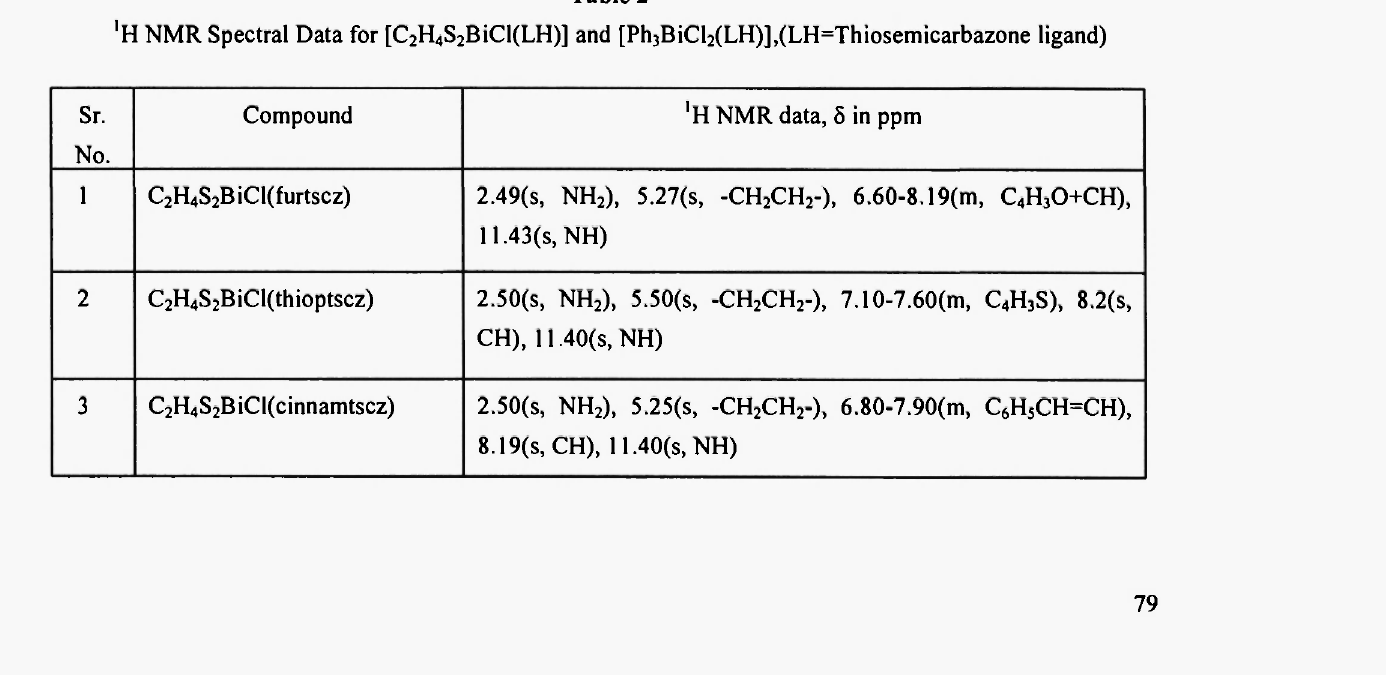
'H NMR Spectral Data for [C 2 H 4 S 2 BiCl(LH)] and [Ph 3 BiCl 2 (LH)],(LH=Thiosemicarbazone